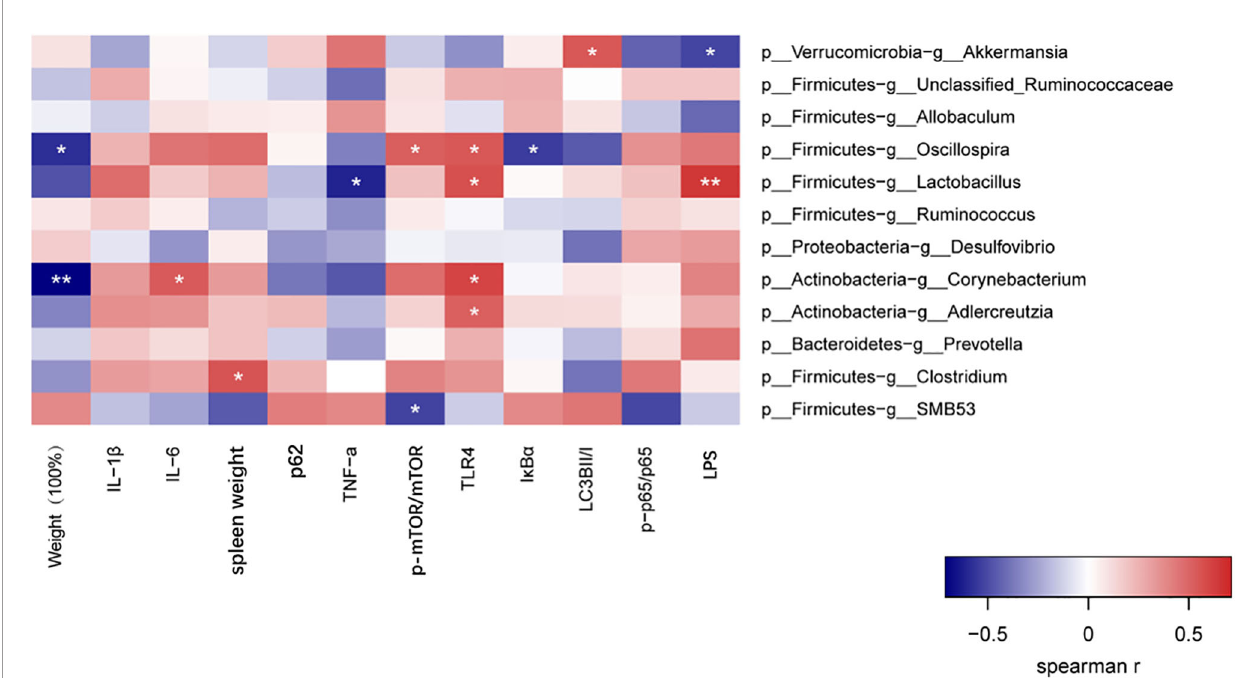
FIGURE 5 | Spearman correlation analysis of the bacterial genera with highest abundance and phenotypes. *P < 0.05, **P < w fi